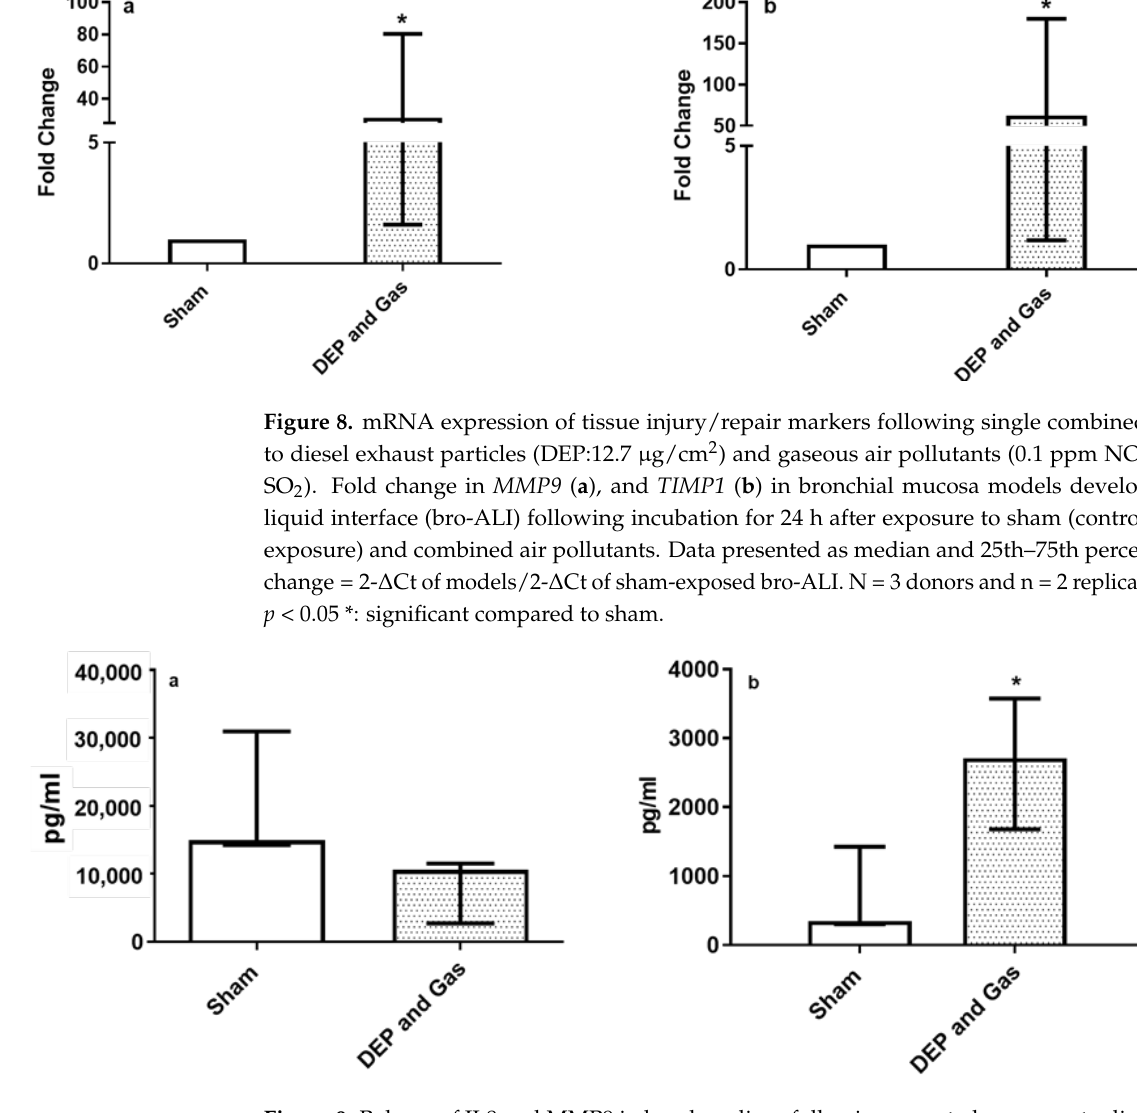
Figure 9. Release of IL8 and MMP9 in basal medium following repeated exposure to diesel exhaust particles (DEP:12.7 µg/cm 2 ) and gaseous air pollutants (0.1 ppm NO 2 , 0.2 ppm SO 2 ). Concentration of IL8 ( a ) and MMP9 ( b ) in bronchial mucosa models developed at air–liquid interface (bro-ALI) following incubation for 24 h after exposure to sham (control: clean air exposure) and combined air pollutants. Data presented as median and 25th–75th percentiles (N = 3 donors and n = 2 replicates/donor). p < 0.05 *: significant compared to sham.